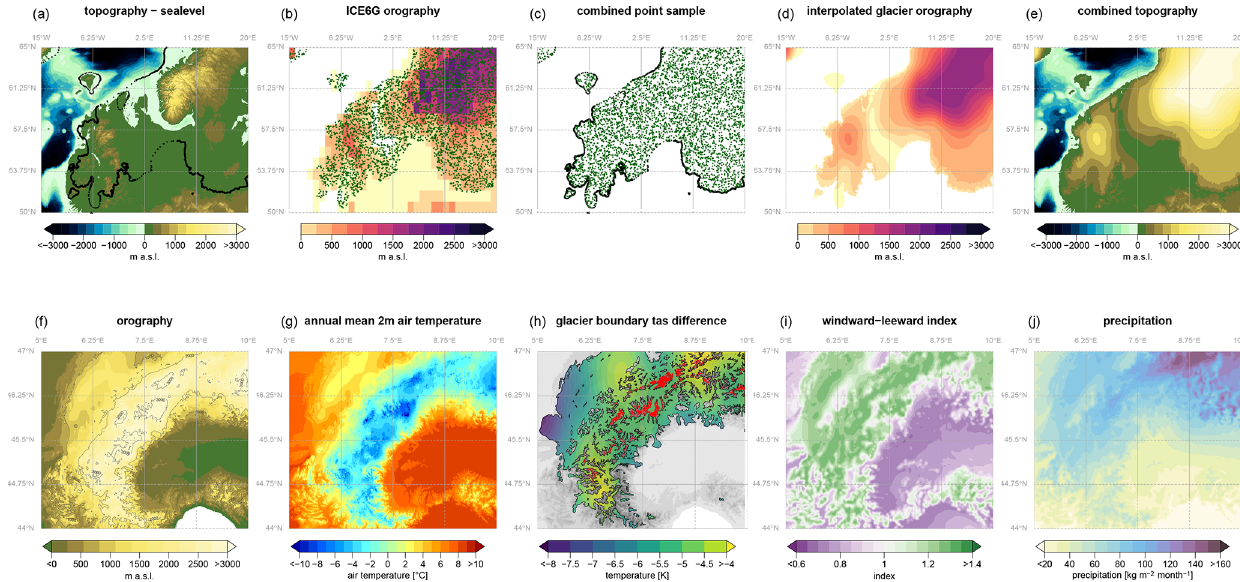
Figure 2. Illustration of several steps performed to estimate the surface orography and the temperature and precipitation fields in CHELSA- TraCE21k during the Last Glacial Maximum (21ka). The upper row gives an example of the interpolation of the European ice sheets; the lower row shows an example of the resulting orography and environmental variables in the western part of the European Alps. (a) Topographic information at t = 0 (LGM) is combined with information on past sea levels and the boundary of ice sheets (black dots) for which the surface elevation is extracted. (b) Within the extent of ice sheets, surface elevation is extracted from the ICE6G orography for a random sample of points for t = 0. (c) Both point samples from (a) and (b) are combined and interpolated (d) to estimate the orography of the glaciers. (e) The interpolated glacier orography and the sea-level-adjusted topography are then combined. (f) The high-resolution (30arcsec) orography (shown here for the western Alps) is then used as a basis at t = 0 for (g) a lapse-rate-based downscaling of air temperature. (h) From the high- resolution temperatures, information on the glacier boundaries during the LGM (black) and current times (red) is extracted, and the difference is interpolated to correct the temperature-based shrinking and expansion of the glaciers. (i) Based on the orography the windward–leeward index is calculated (shown for July 21ka), which builds the basis for the (j) precipitation approximation.